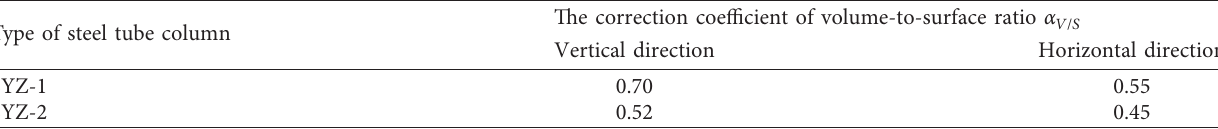
It should be explained here that, before the day t 0 of the maximum expansion strains that can be achieved, the parameter A 0 is a variable; and then it is the constant value. According to the time 0 − t 0 in Table 6, the parameter A 0 is interpolated linearly according to 0 − A 0 . Table 7: The correction coefficient of volume-to-surface ratio of massive self-compacting concrete.